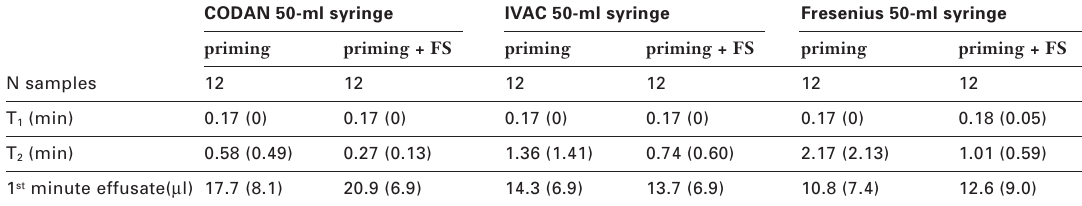
Time from starting infusion pump at an infusion rate of 1ml.h –1 to first fluid delivery (T 1 ), time to first pre-set flow (T 2 ), and first- minute effusate in three different syringe brands with and without FASTSTART after priming the infusion system. Results are shown as mean (SD). Results for T 2 differed significantly between syringes (all p = 0.0023) and between FASTSTART/no FAST- START (all p = 0.01) but did not differ for T 1 . Boluses were significantly different across syringes (all p <0.0001) but not according to whether FASTSTART was switched on or